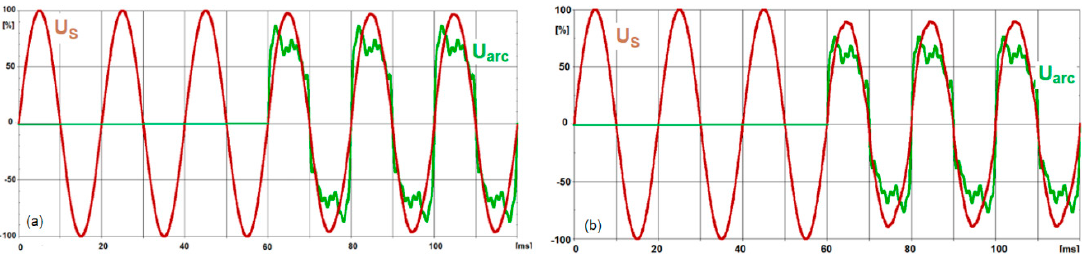
Figure 21. The waveforms of the arc voltage at the initial stage of melting: ( a ) measured ( b ) determined by a multi-voltage model.